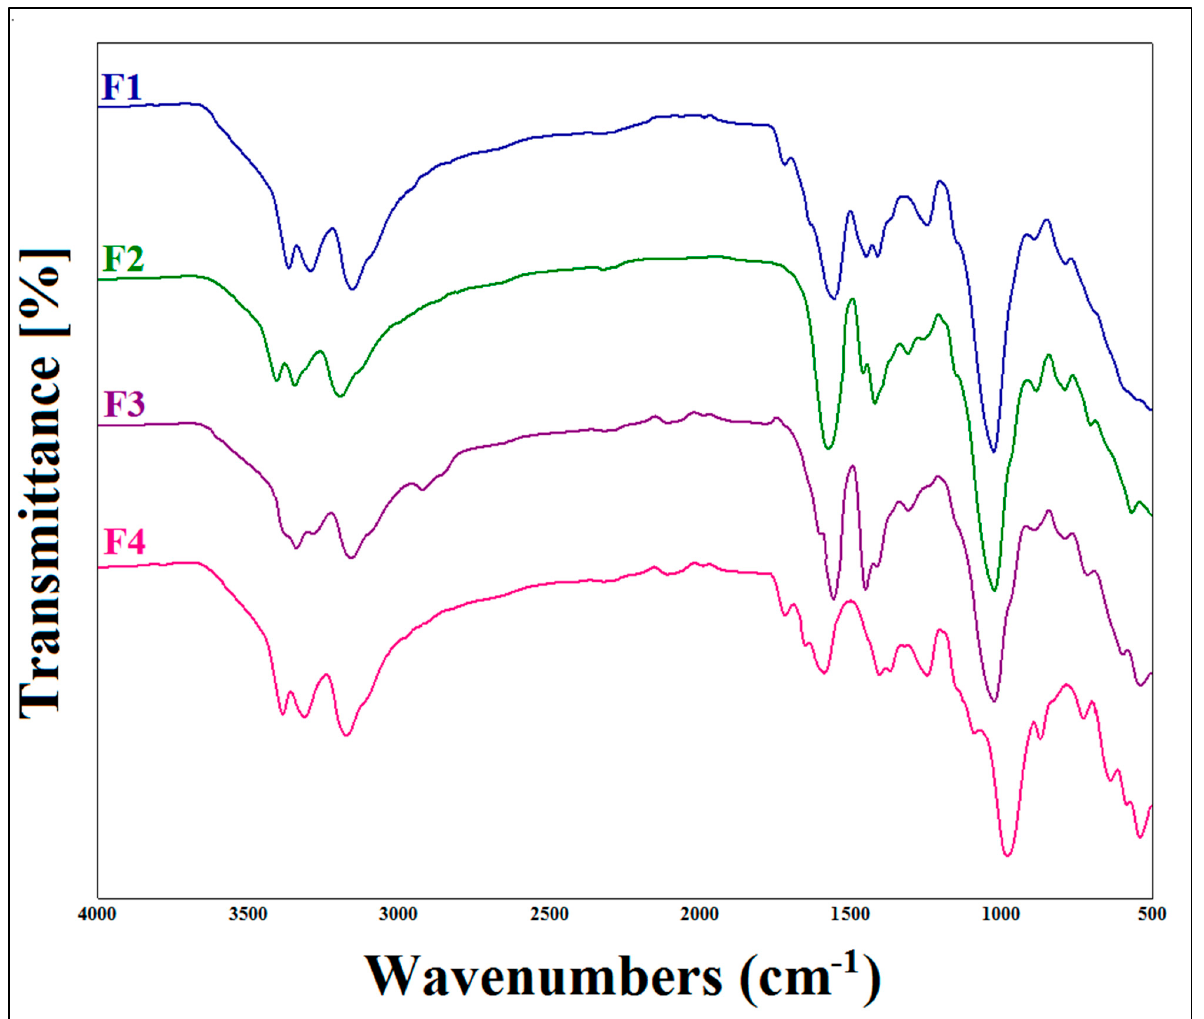
Figure 2. FTIR spectra of metformin hydrochloride (MTH) microparticles at different concentrations of xanthan gum.